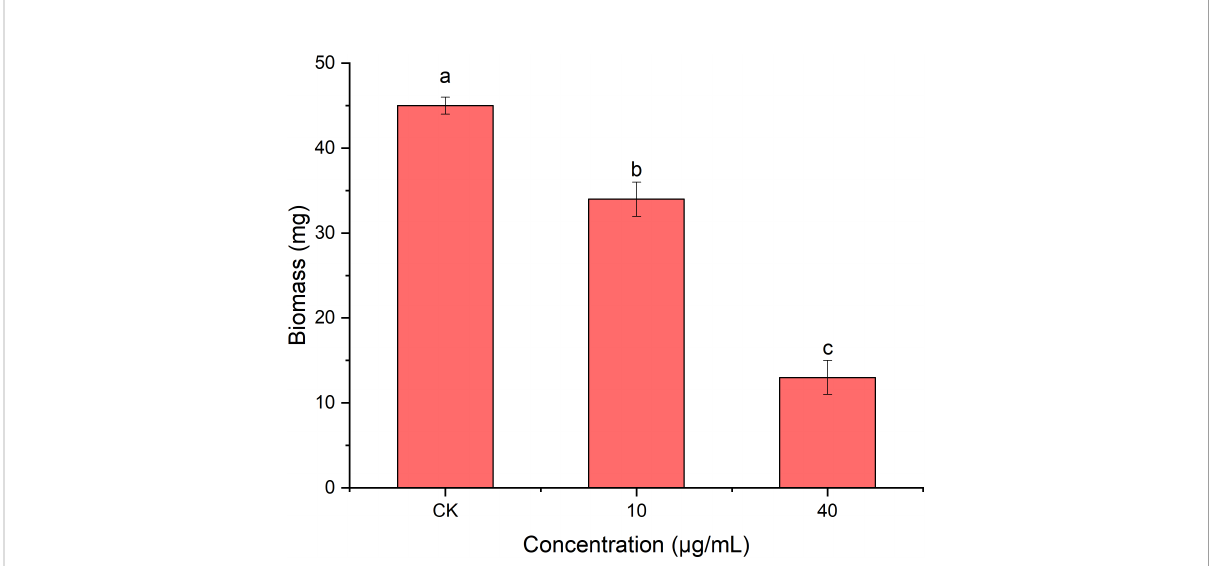
FIGURE 7 Effect of the antifungal compound PCN on the biomass of R. solani AG1IA. Different lowercase letters indicate signi fi cant differences ( P < 0.05